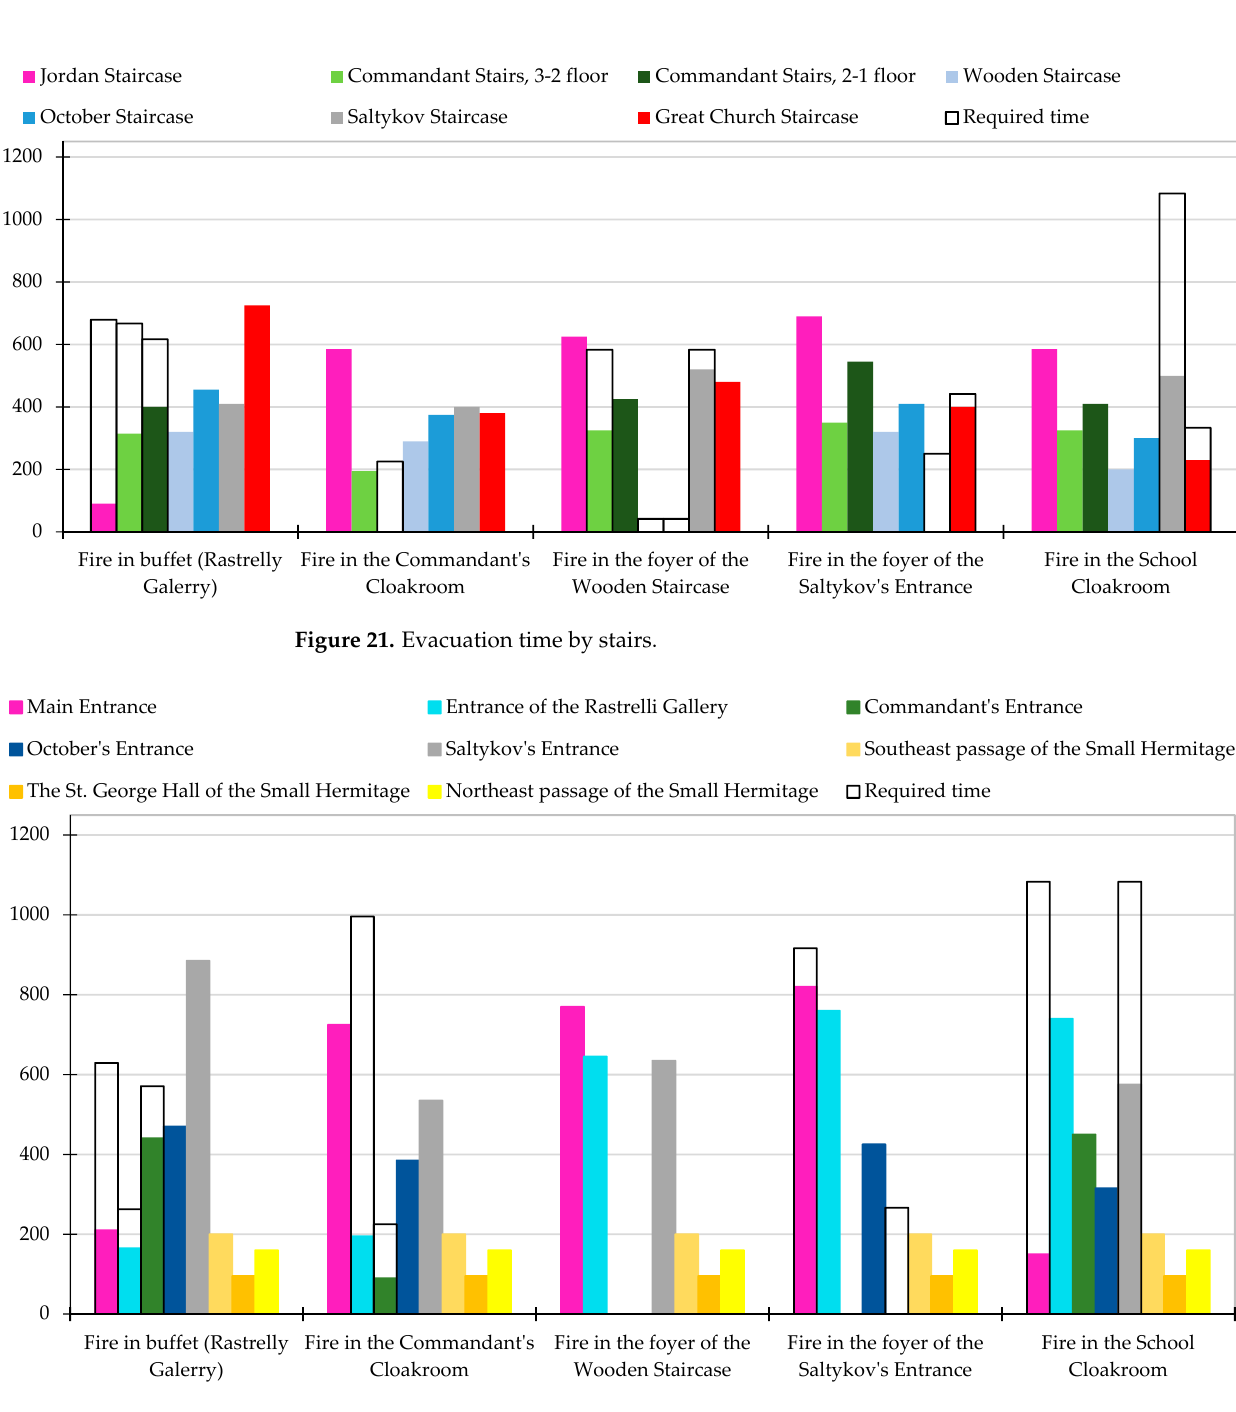
Figure 20. Distribution of people to the exits of the building.